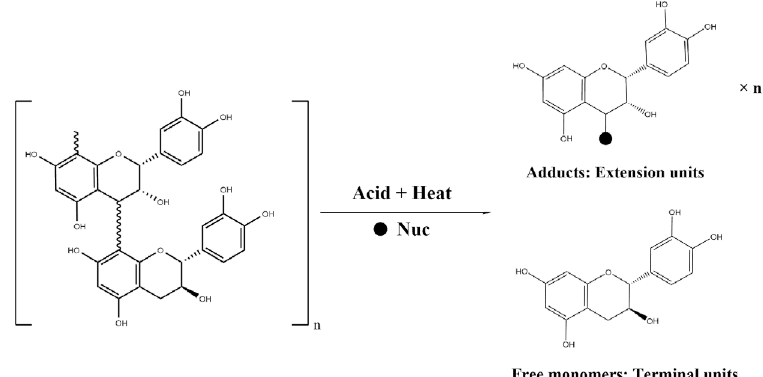
Figure 4. Nucleophilic reagent hydrolysis of condensed tannins under heated acid condition. Nuc: abbreviation for nucleophilic reagent.